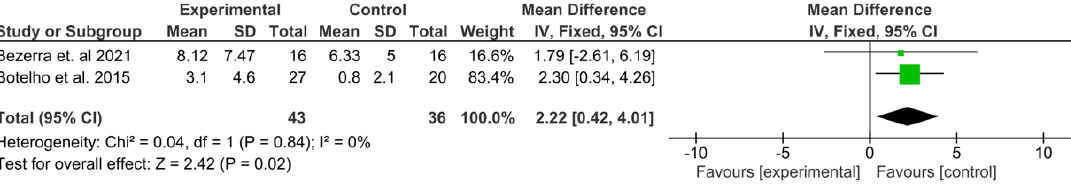
Figure 3. Comparison of experimental and control, according to ICIQ UI-SF. SD: standard deviation; 95% CI: 95% confidence interval.